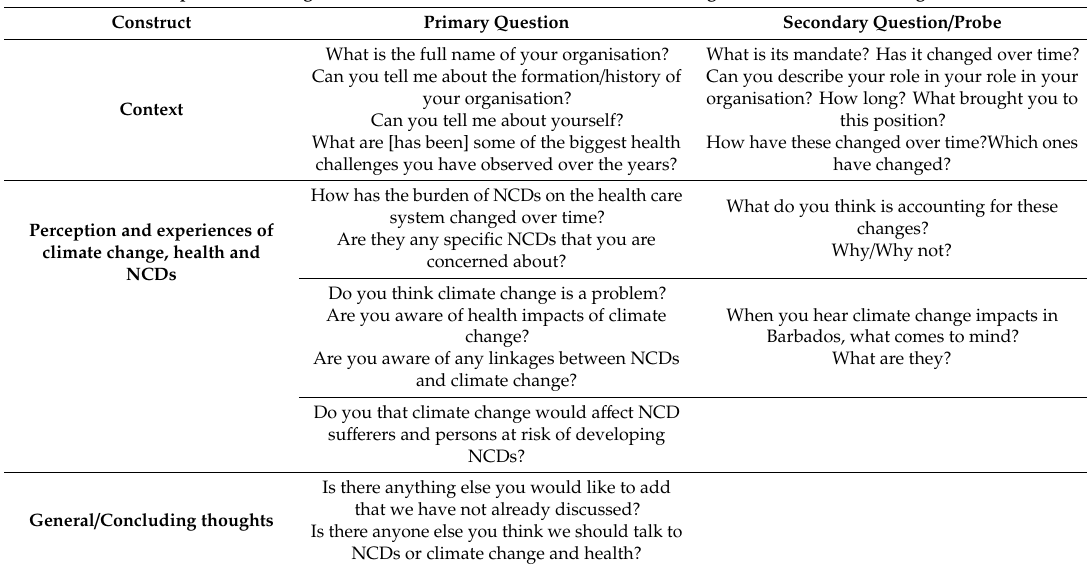
Sample Interview Questions from semi-structured Interview Guide with Key informants /